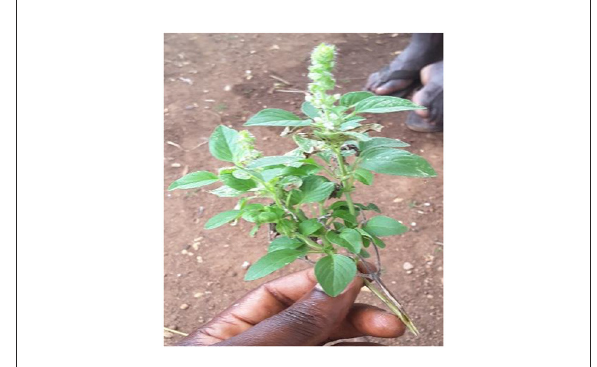
FIGURE6 Basil herbal plant used by some farmers to treat maize grain.